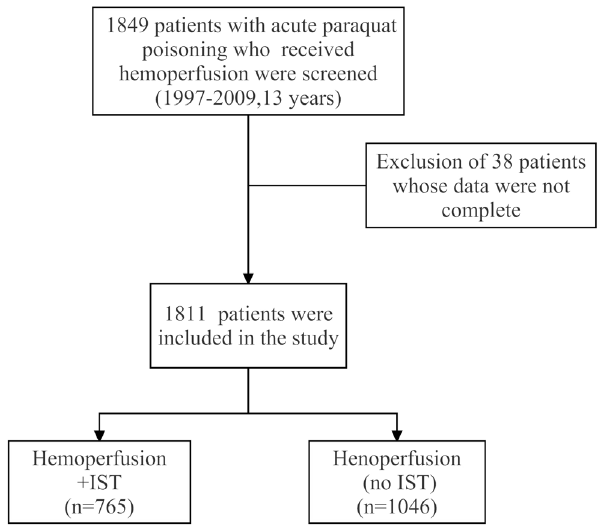
Figure 1. Selection and grouping of the patients with paraquat poisoning. Abbreviations: IST: Immunosuppressive